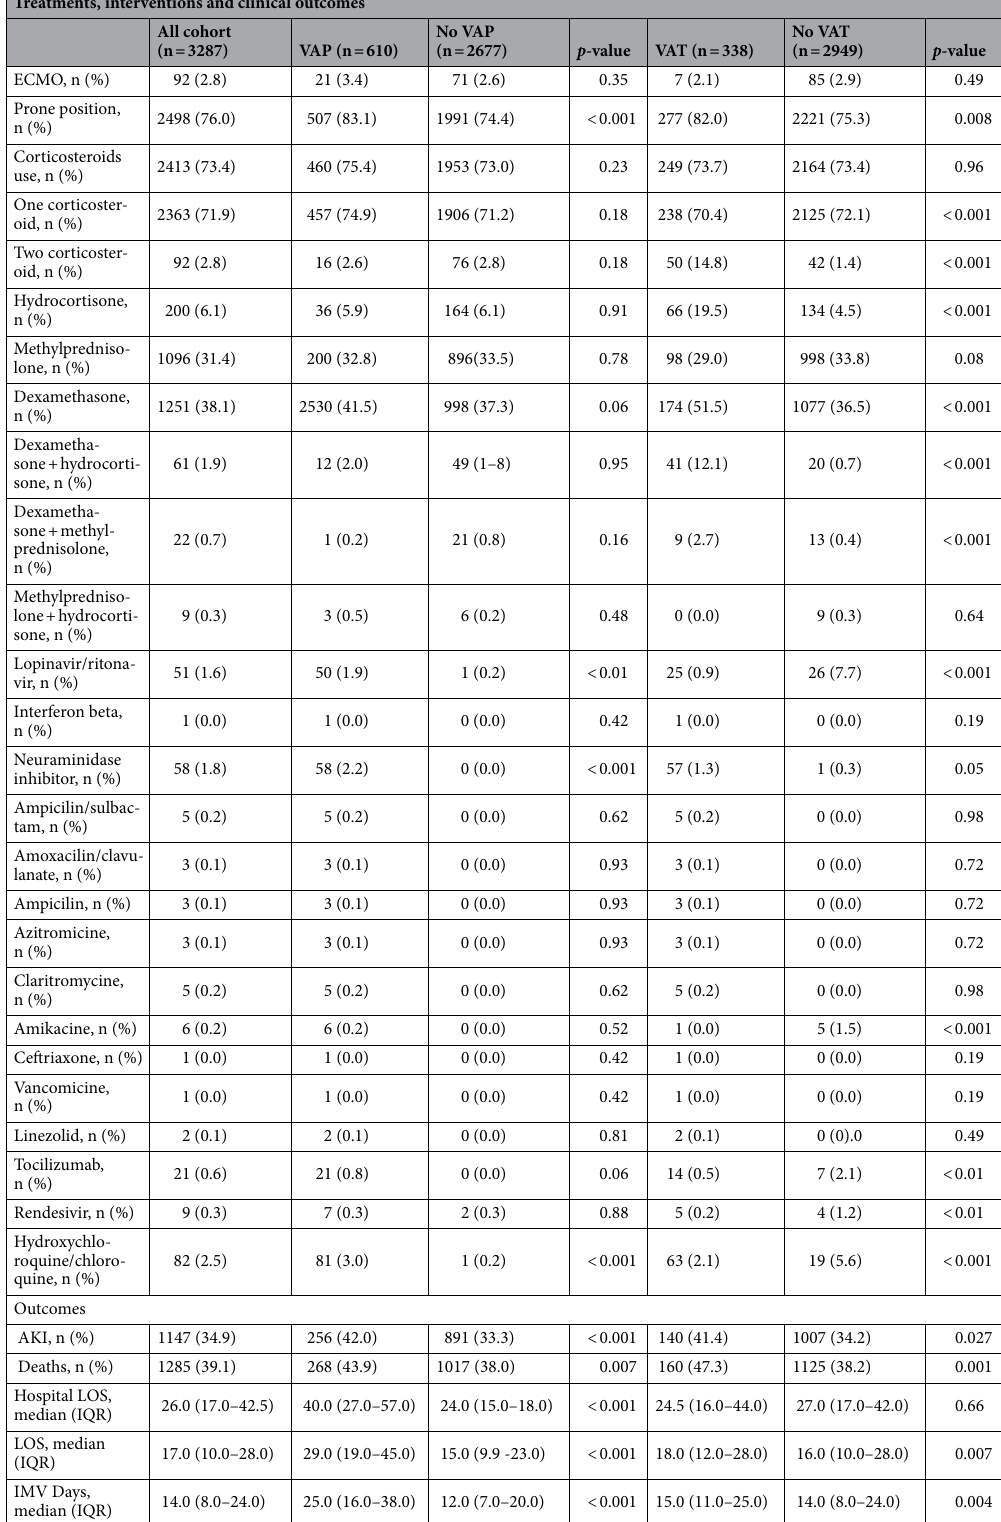
Table 3. Treatment, interventions, and outcomes of the general cohort and VA-LRTI discriminated by patients that developed VAP and